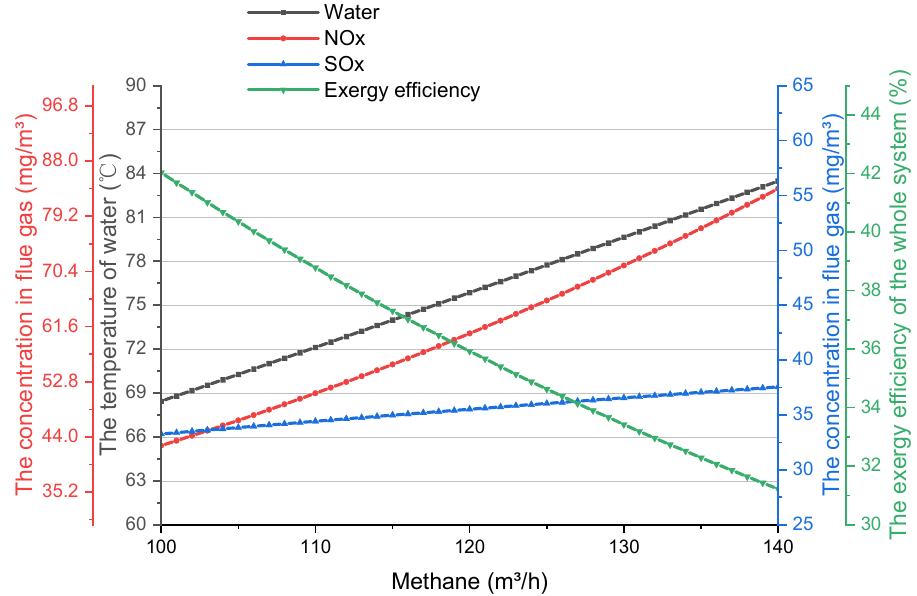
Figure 8. Sensitivity analysis as the function of flowrate of methane.